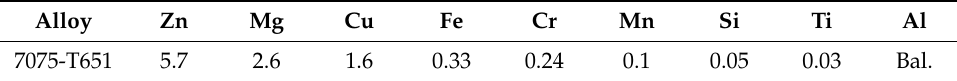
Table 1. Chemical compositions (wt%) of the used 7075-T651